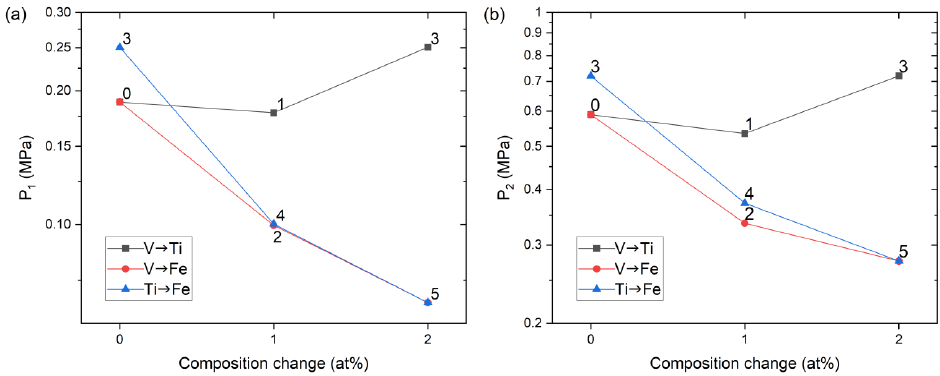
Figure 8. Variation of the desorption plateau pressures ( a ) P 1 and ( b ) P 2 for the three series of the samples in Figure 7. Sample IDs are annotated. In the legend, V → Ti denotes that V replaces Ti and likewise for the other